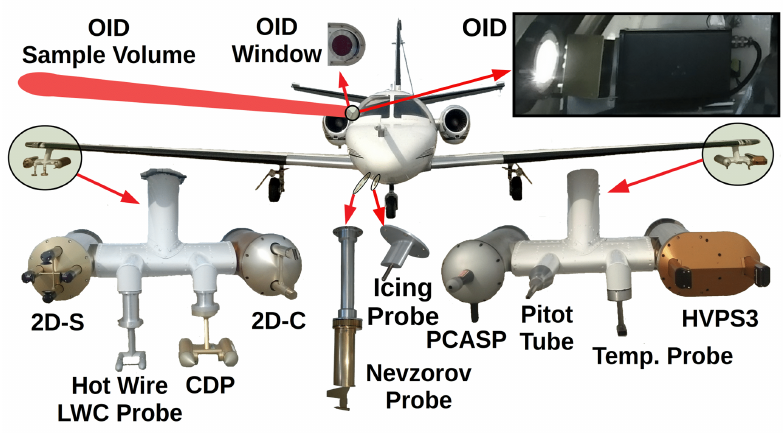
Figure 2. Image showing the North Dakota Citation Research Aircraft, with an enlarged view of the wing-tip pylons, the Nevzorov probe, and the Rosemount icing probe, as mounted for the 2015 field project over Cape Canaveral, Florida (CAPE2015). OID Window (upper center) is the viewing port through the pressurized cabin for the Optical Ice Detector (OID). The OID is angled slightly (10 to 15 ◦ ) forward of the wing so the sampling region (OID Sample Volume) is in front of and above the right wing. An image of the OID in the Citation fuselage is shown in the upper right. The cloud droplet probe (CDP) measures particles from 2 to 50µm (30 channels) using forward light scattering. The two-dimensional stereo (2D-S) probe measures particles using shadowed diodes (two (one horizontal and one vertical) 128 element arrays) of 10µm. The High-Volume Precipitation Spectrometer Version 3 (HVPS3) measures particles using shadow diodes (128 element array) of 150µm. The Two Dimensional Cloud probe (2D-C) is an older probe that also measures particles using shadowed diodes (32 element array) of 30µm. The Rosemount icing probe detects supercooled liquid water using a vibrating metal rod. The Nevzorov probe is a hot-wire probe that measures liquid and total water content (TWC). Subtracting the liquid water content LWC from the TWC determines the ice water content (IWC). The King hot-wire liquid water content probe is an older probe that only measures LWC. The passive cavity aerosol spectrometer probe (PCASP) model measures aerosols from 0.1 to 3.0µm. The Rosemount temperature probe (temp. probe) measures ambient air temperature, and the pitot tube measures airspeed using a differential pressure transducer connected to a static and a forward-facing